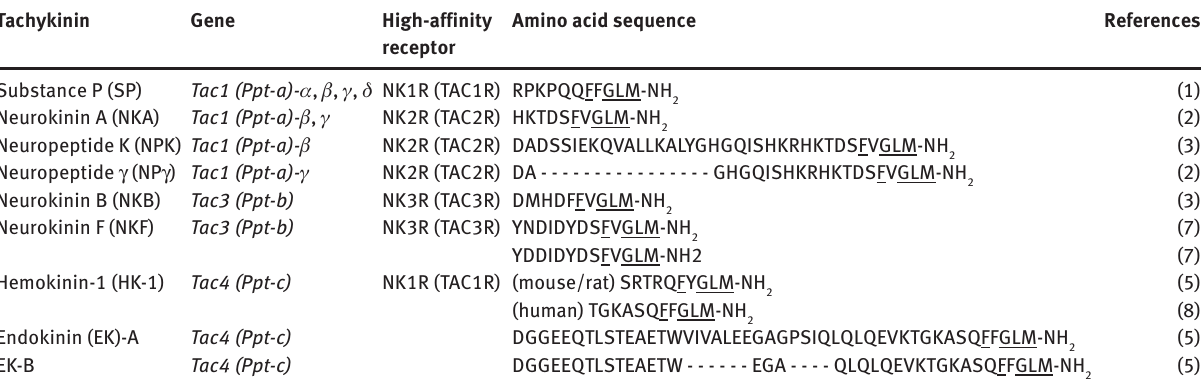
Broken lines incidate lacking amino acid residues. Ppt-a, preprotachykinin A; Ppt-b, preprotachykinin B; Ppt-c, preprotachykinin